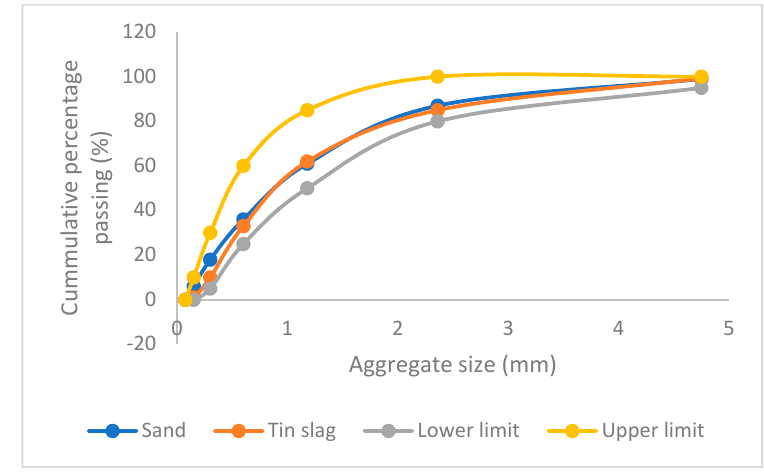
Figure 3. Second sieve analysis.